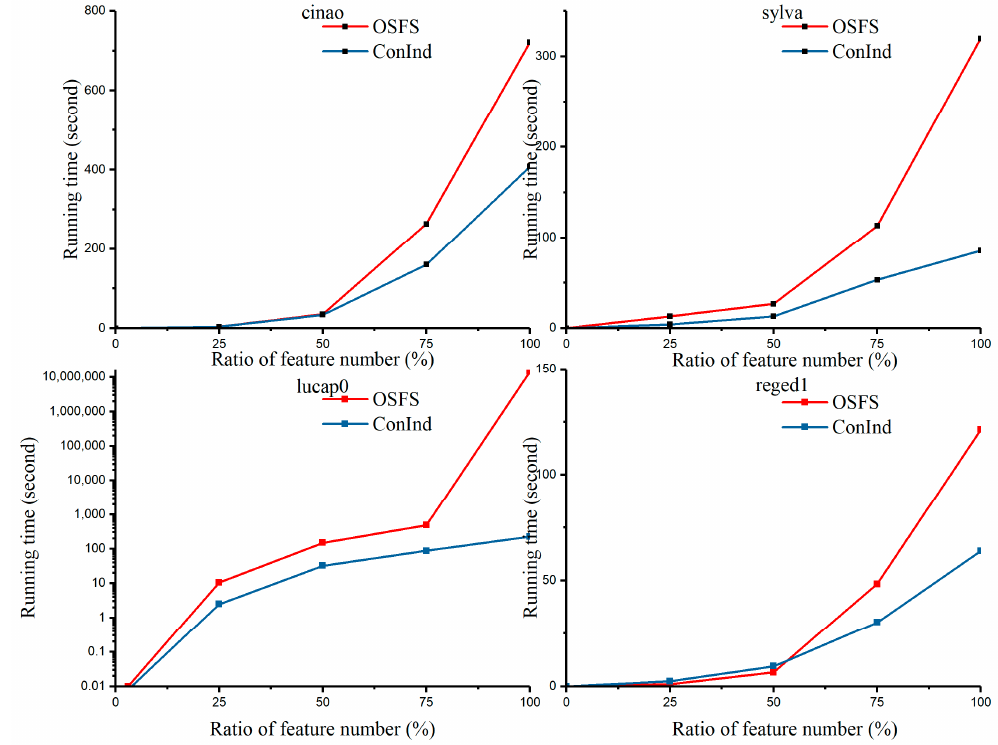
Figure 8. The variation in running time with increase in ratio feature number in datasets with low redundancy and high relevance.